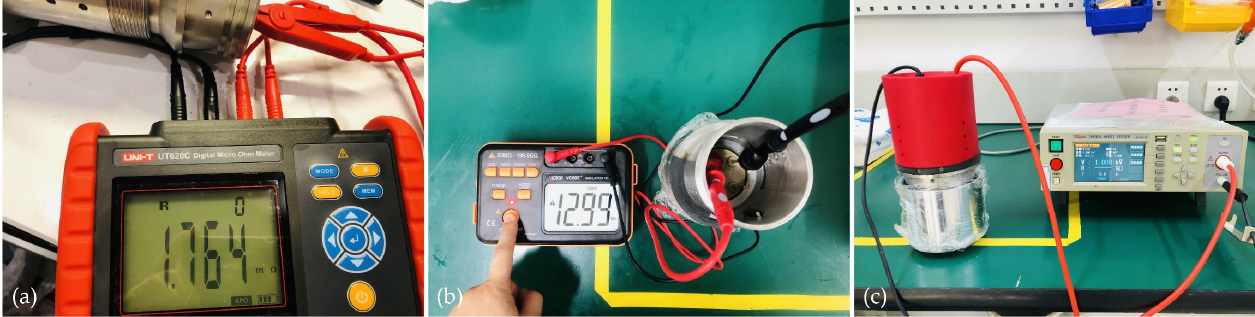
Figure 17. Electrical testing of the prototype: ( a ) contact resistance test, ( b ) insulation resistance test,